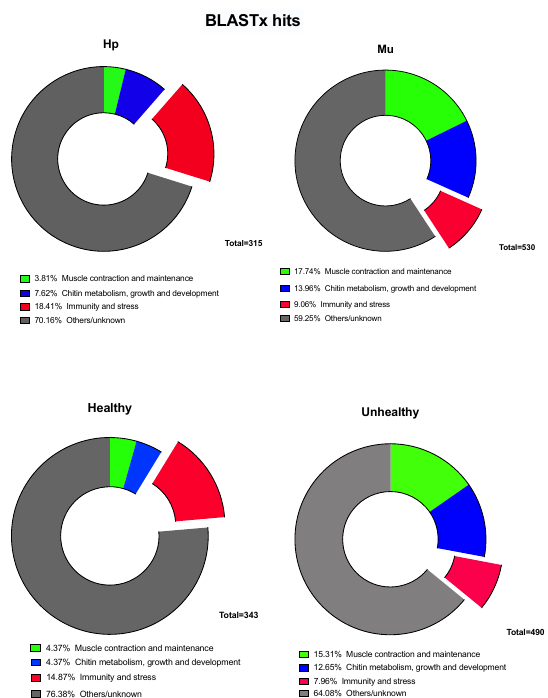
Figure 2. The most expressed genes identified in the transcriptome of hepatopancreas (Hp) and muscle (Mu) of WSSV-negative (healthy) and WSSV-positive (Unhealthy) Litopenaeus vannamei shrimps, with BLASTx hits in arthropod species. The part highlighted in light red represents the immune and stress genes. WSSV: White Spot Syndrome Virus.